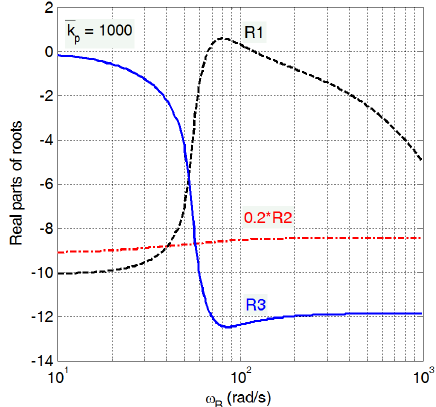
Figure 3. The real parts of characteristic roots for the standard cascade